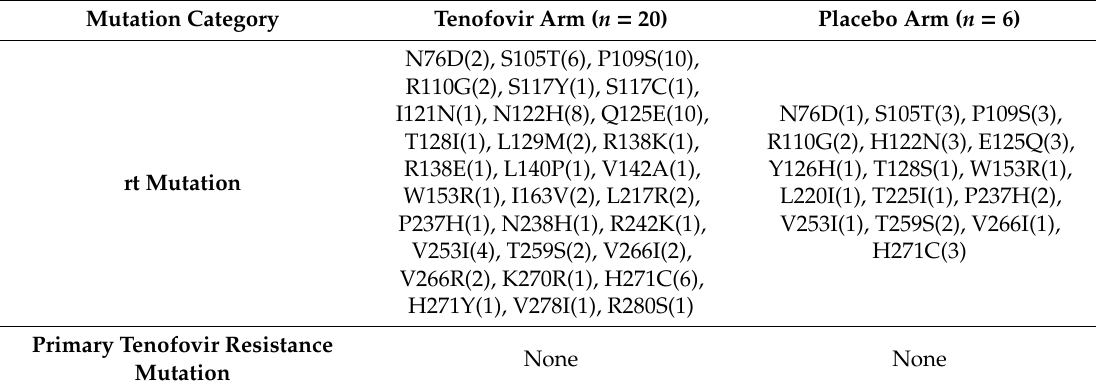
Figure 2. Independent amino acid mutations in the HBVrt domain among women assigned to the ( a ) tenofovir and ( b ) placebo gel arms. GenBank accession number reference sequence X02763 is shown in detail. Each functional domain (A–E) of the HBV RT region is indicated by an alphabetical letter in the shaded box.